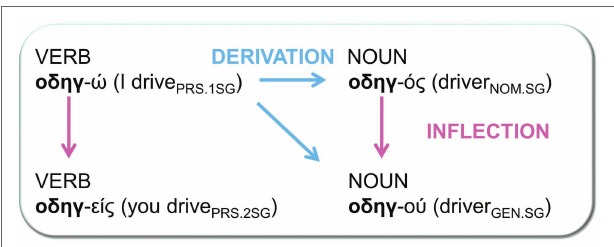
FIGURE 1 | Example of inflectional and derivational process in nouns and verbs using the same